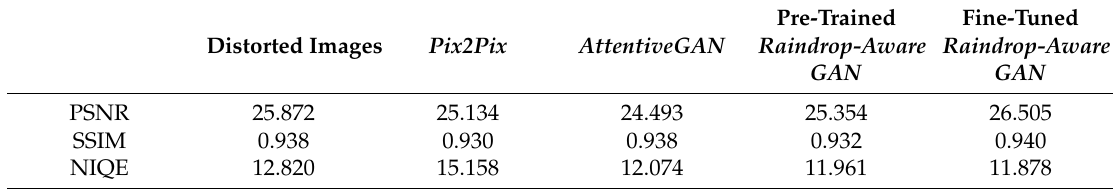
Table 2. Accuracy and image quality assessment of the tested methods on Anmok paired dataset .